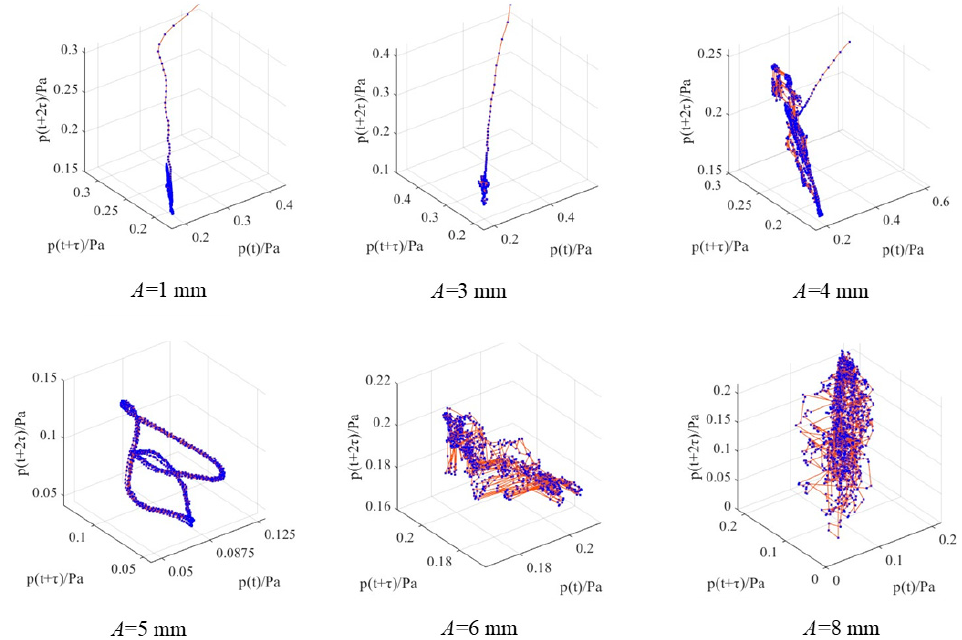
Figure 14. Phase space trajectories for different